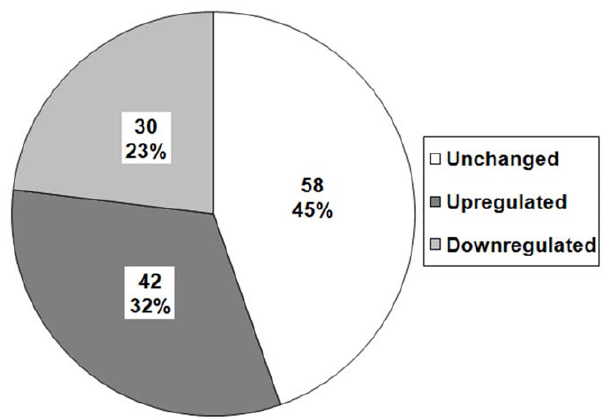
Figure 4. p300 interactome transcription factors. Transcription factors in the p300 interactome which demonstrated significant regulation during A404 differentiation vs. untreated cells (FDR , 1). White = unchanged. Light grey = upregulated. Dark grey = downregulated. Gene number and % of interactome shown for each section.